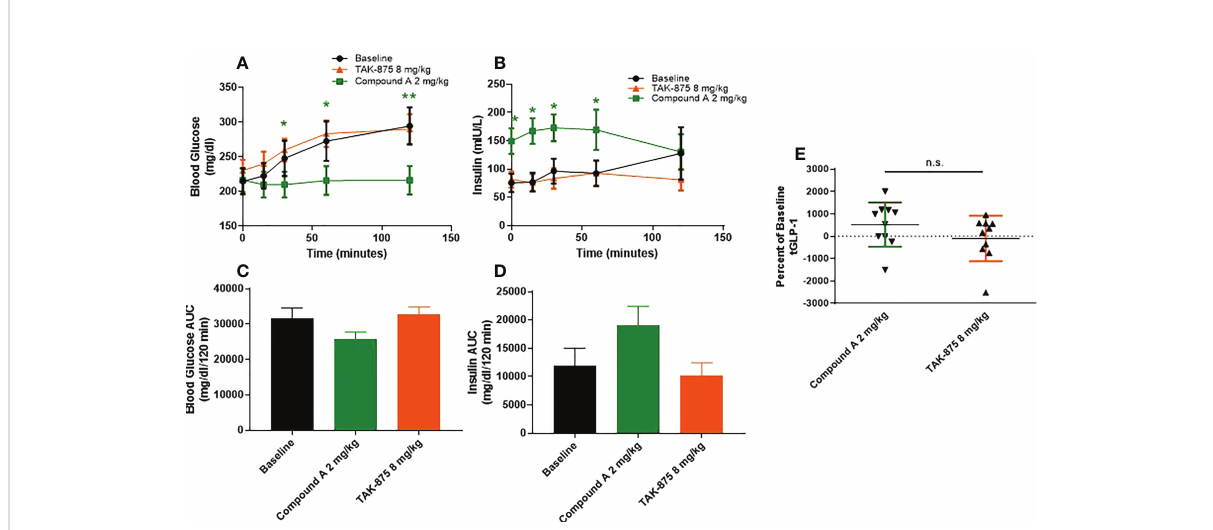
FIGURE 2 Glucose metabolism and GLP1 secretion in spontaneous T2D cynomolgous monkeys. Oral glucose tolerance test was performed in diabetic non-human primates with compound A.Compound was dosed 60 minutes prior to challenge with glucose (at 0 minutes). (A) Plasma glucose, (B) insulin secretion, and (C) plasma total GLP1 were measured. (D, E) AUCs of blood glucose and insulin secretion were caluclated from x=0, y=0 of respective graphs. n=10 per group, * = p ≤ 0.05, ** = p ≤ 0.01, n.s. = p>0.05 compound A to baseline by t-test.